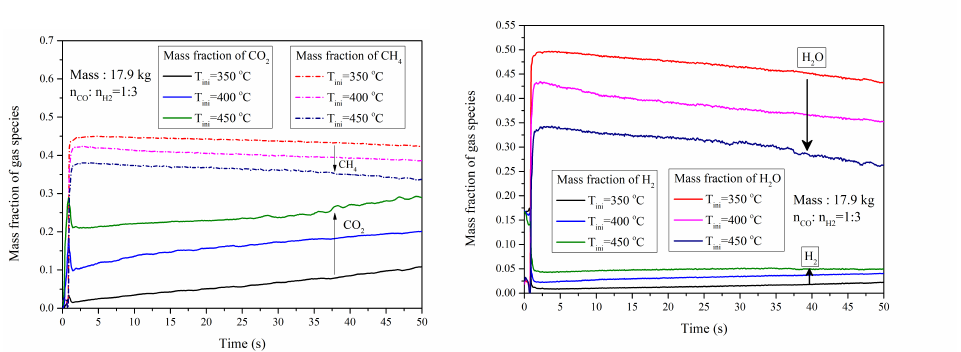
Figure 14. Time-evolution of gas species mass fraction under different temperatures. Gas inlet rate is 0.018 kg/s. Solid inventory is 17.9 kg.